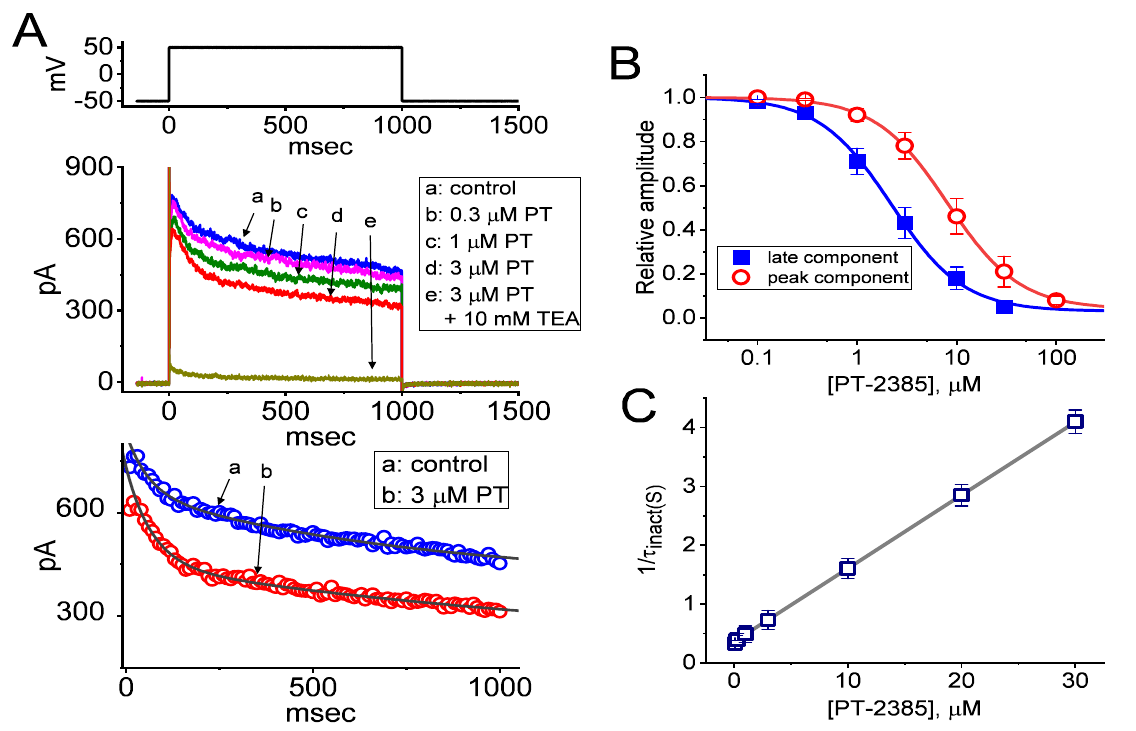
Figure 1. Inhibitory effect of PT-2385 (PT) on delayed-rectifier K + current ( I K(DR) ) measured from pituitary tumor (GH 3 ) cells. Whole-cell patch-clamp experiments were undertaken via experimented cells in Ca 2+ -free Tyrode’s solution containing 1 µ M tetrodotoxin (TTX) and 0.5 mM CdCl 2 , while the recording pipet was filled with K + -containing solution. In the upper part of ( A ), representative I K(DR) tracings were obtained for the control (i.e., PT-2385 was not present, (a)), and during cell exposure to 0.3 µ M PT-2385 (b), 1 µ M PT-2385 (c), 3 µ M PT-2385 (d), or 3 µ M PT-2385 plus 10 mM tetraethylammonium chloride (TEA). The voltage-clamp profile is illustrated in the uppermost part. In the lower part of ( A ), the time courses of current inactivation in the absence (a) and presence (b) of 3 µ M PT-2385 were well approximated by a 2-exponential decay (indicated in gray smooth line). The values of fast or slow components (i.e., τ inact(S) ) in the inactivation time constants of I K(DR) obtained in the absence and presence of 3 µ M PT-2385 were 63 or 1514 msec, and 61 or 786 msec, respectively. ( B ) The concentration–response curve of PT-2385-induced block of peak or late I K(DR) occurring in GH 3 cells. The continuous line represents the best fit to the modified Hill equation, as elaborated in the Materials and Methods. The IC 50 values for PT-2385-induced inhibition of peak or late I K(DR) were reliably estimated to be 8.1 or 2.2 µ M, respectively. Each point represents the mean ± SEM ( n = 9–12). ( C ) Relationship of the PT-2385 concentration as a function of the slow component in the inactivation rate constant (1/ τ inact(S) ) (mean ± SEM; n = 8 for each point). Of note, the value of 1/ τ inact(S) is directly proportional to the PT-2385 concentration. Based on a minimal reaction scheme elaborated in the text, the value of k +1* or k − 1 was estimated to be 0.124 s − 1 µ M − 1 or 0.362 s − 1 , respectively; hence, the K D value ( k − 1 / k +1 * , i.e., dissociation constant) turned out to be 0.036 µ M (or 36 nM), a value which is closely similar to the IC 50 value required for its inhibitory effect on late I K(DR)